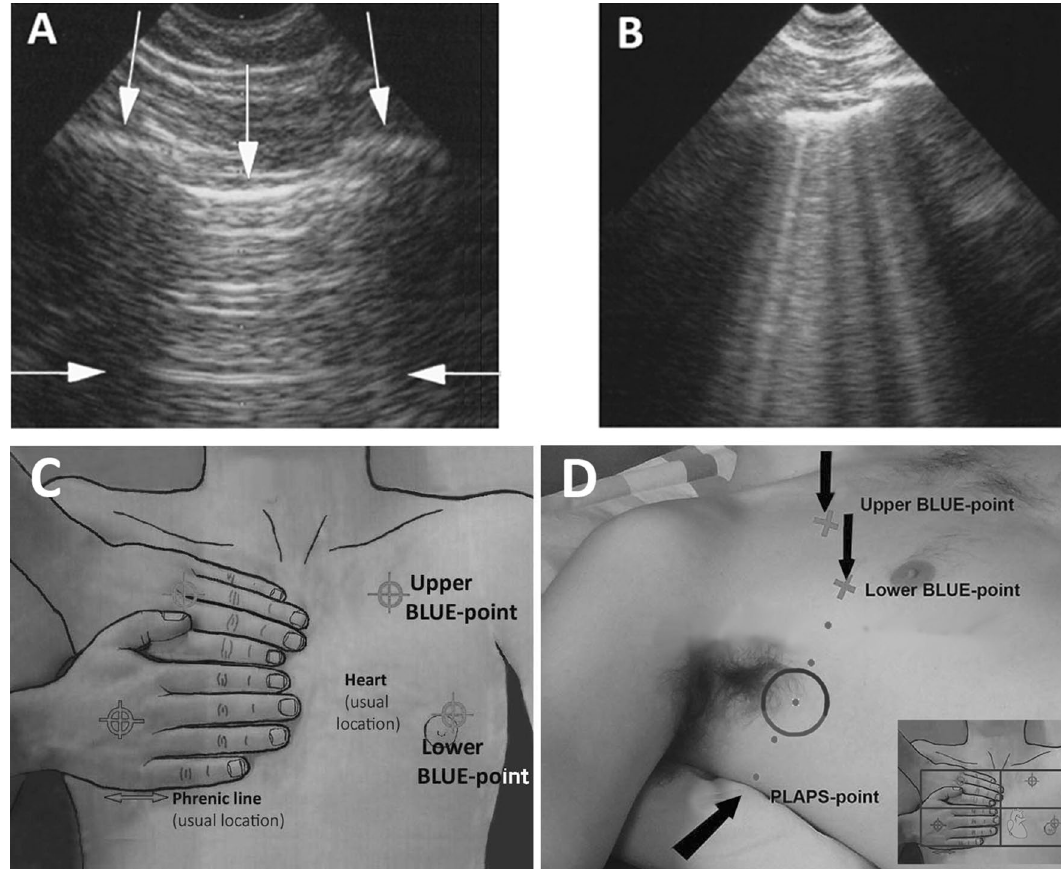
Figure 1. ( A ) Pleural line (vertical arrows indicate the bat sign, with ribs and pleural line). One A-line at the standardized location (horizontal arrows). ( B ) B-lines. 6 B-lines visible between two ribs in short-axis. ( C ) BLUE-points . The BLUE-protocol uses three points per lung. Two hands are applied this way, against the clavicule. Two points are anterior, the upper-BLUE-point (middle of upper hand, that is, roughly, second intercostal space between parasternal and anterior axillary line) and the lower-BLUE-point (middle of lower palm). One point, continuing transversally the lower BLUE-point as «posterior as possible, is the posterolateral alveolar pleural syndrome-point» (PLAPS-point). Note that the PLAPS-point seems rather cranial, but is in actual fact just a bit above the diaphragm usually. ( D ) The lateral point . For adapting the approach to the perioperative setting with its constraints in this study, we took a clinically accessible lateral point located transversally between lower BLUE-point and PLAPS-point, and longitudinally between anterior and posterior axillary line. Note that, if a theoretical point is not accessible for any reason, device or other, the BLUE-points are flexible up to a large tolerance (indicated by the areas in the cartouche).